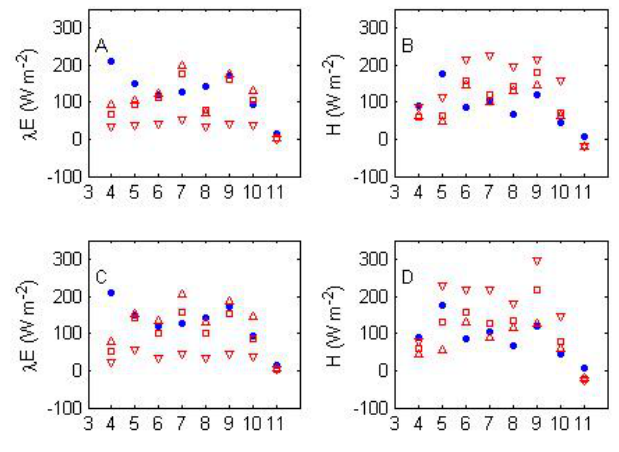
Figure 9. Area-averaged surface fluxes from aircraft (filled circle) and simulations using RAMS land cover ( A , B ) CORINE land cover respectively ( C , D ). The flight numbers on the x-axis are the same as in Table 2. Simulated values are based on: measured initial soil moisture at Norunda tower (square), +10% increase of soil moisture (triangle up) and − 10% decrease of soil moisture (triangle down). The area averaged simulated values are the mean of all grid cells in the finest grid (grid No. 3 in Figure 2).